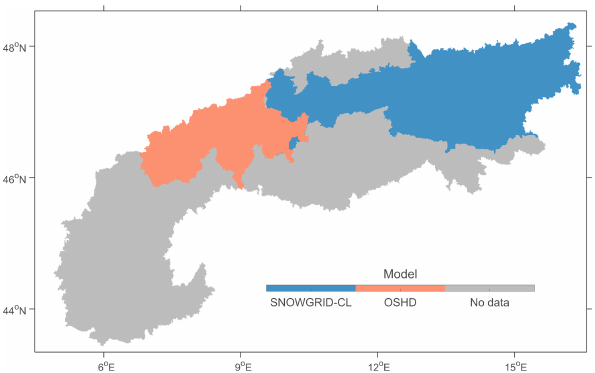
Figure 1. The domains of the 1km resolution SNOWGRID-CL and OSHD model simulations of snow